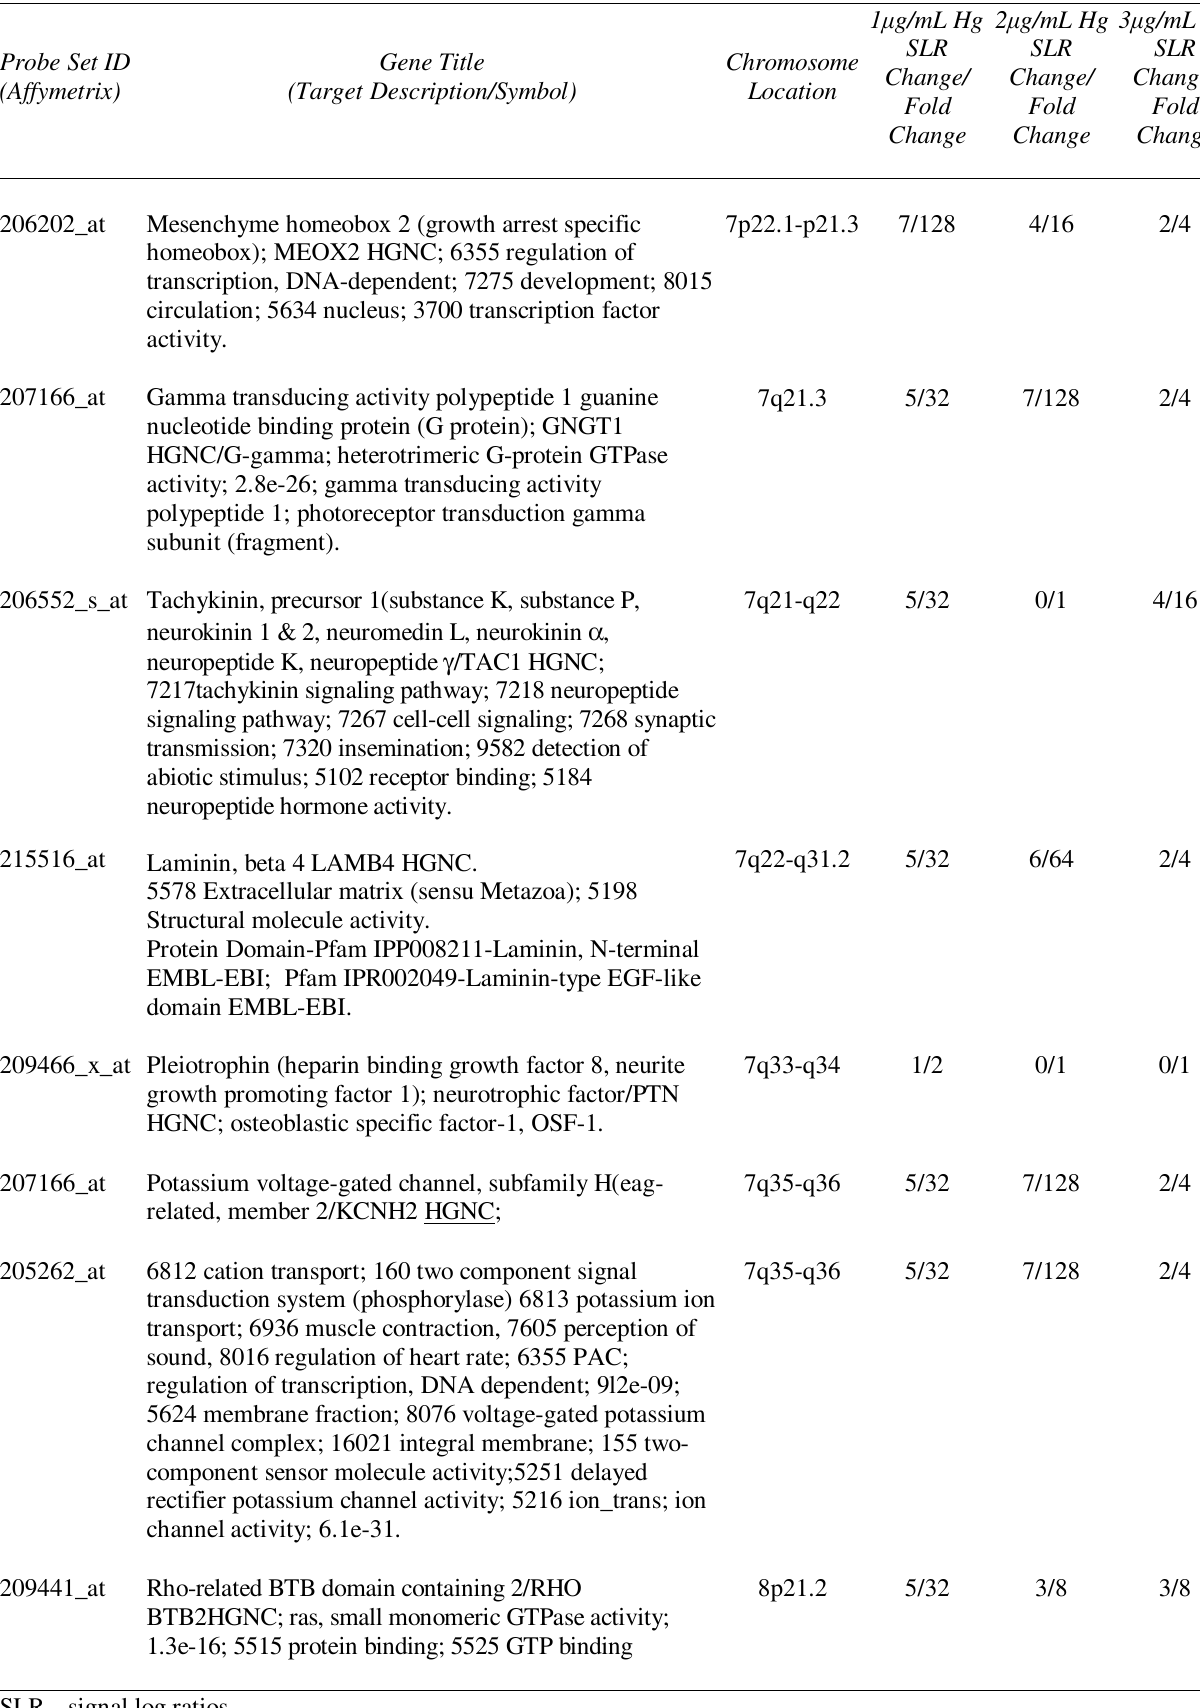
SLR-- signal log ratios